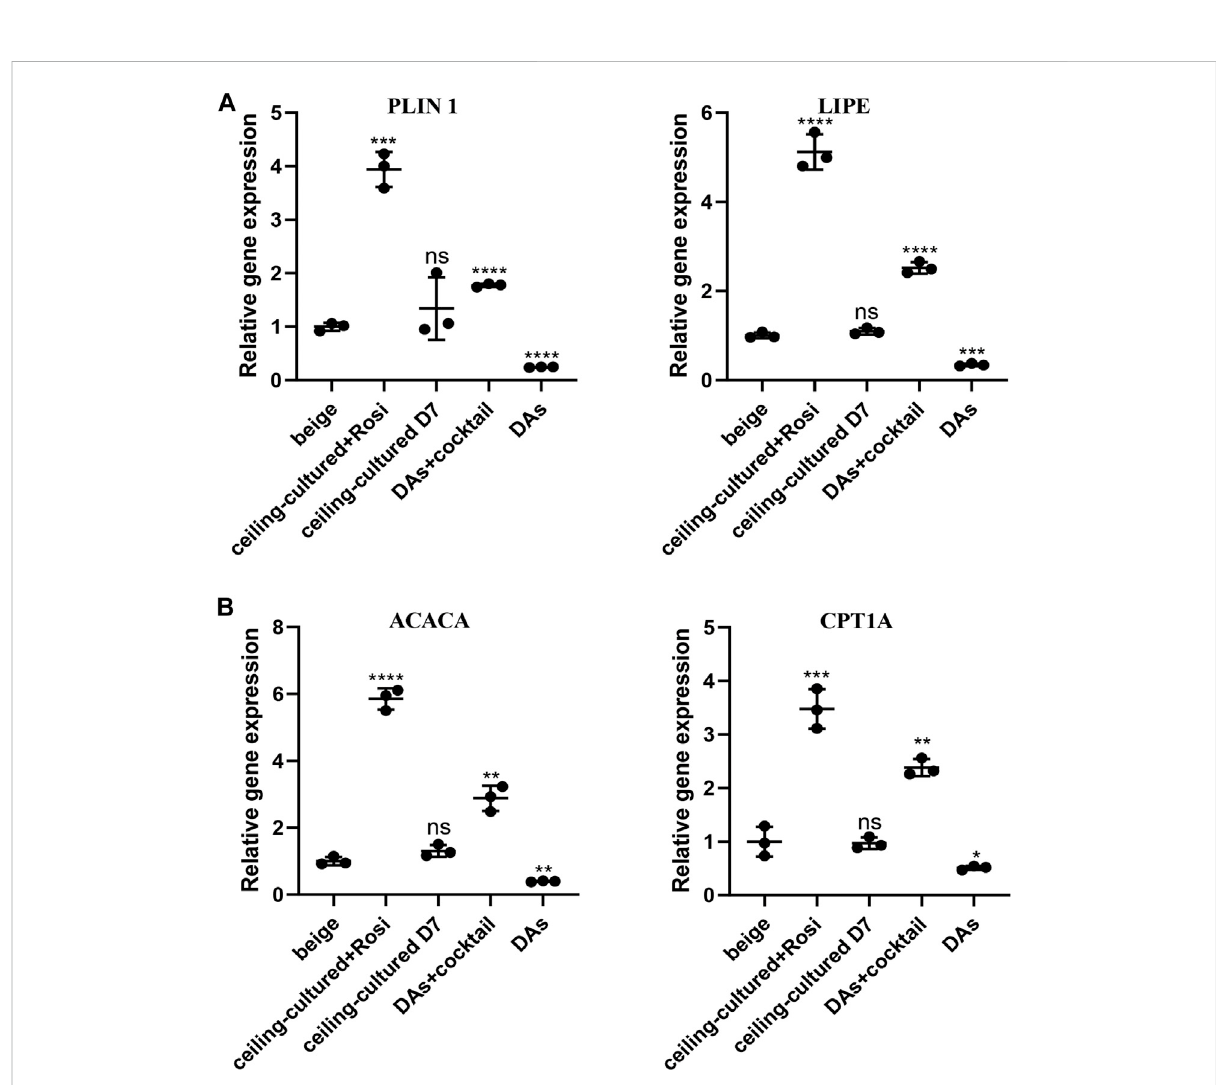
FIGURE 4 Fatty acid metabolism-related gene expression in beige adipocytes. (A) Relative gene expression levels of the lipolysis-related genes PLIN1 and LIPE , normalized to GAPDH as an endogenous control. (B) Relative gene expression levels of the oxidative genes ACACA and CPT1A , normalized to GAPDH as endogenous control. Data are mean ± SEM ( n = 3). ns, non-signi fi cant. * p < 0.05, ** p < 0.01, *** p <